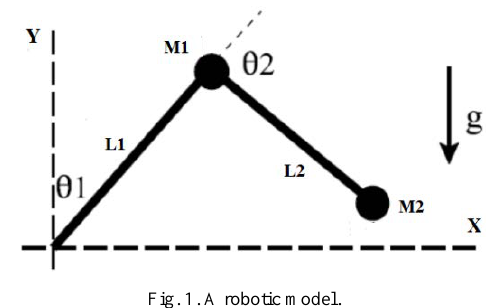
Fig. 1. A robotic